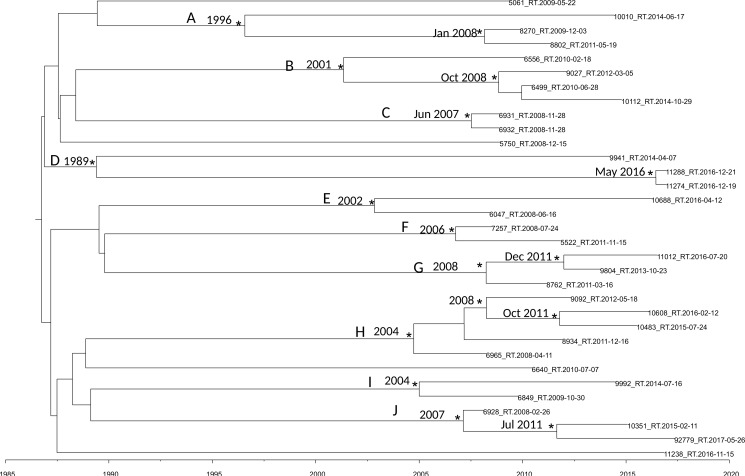
MCC tree of the second dataset. Branches are scaled in time. Significant posterior probability support (pp ≥ 0.9) as indicated by an asterisk. Clusters are highlighted.